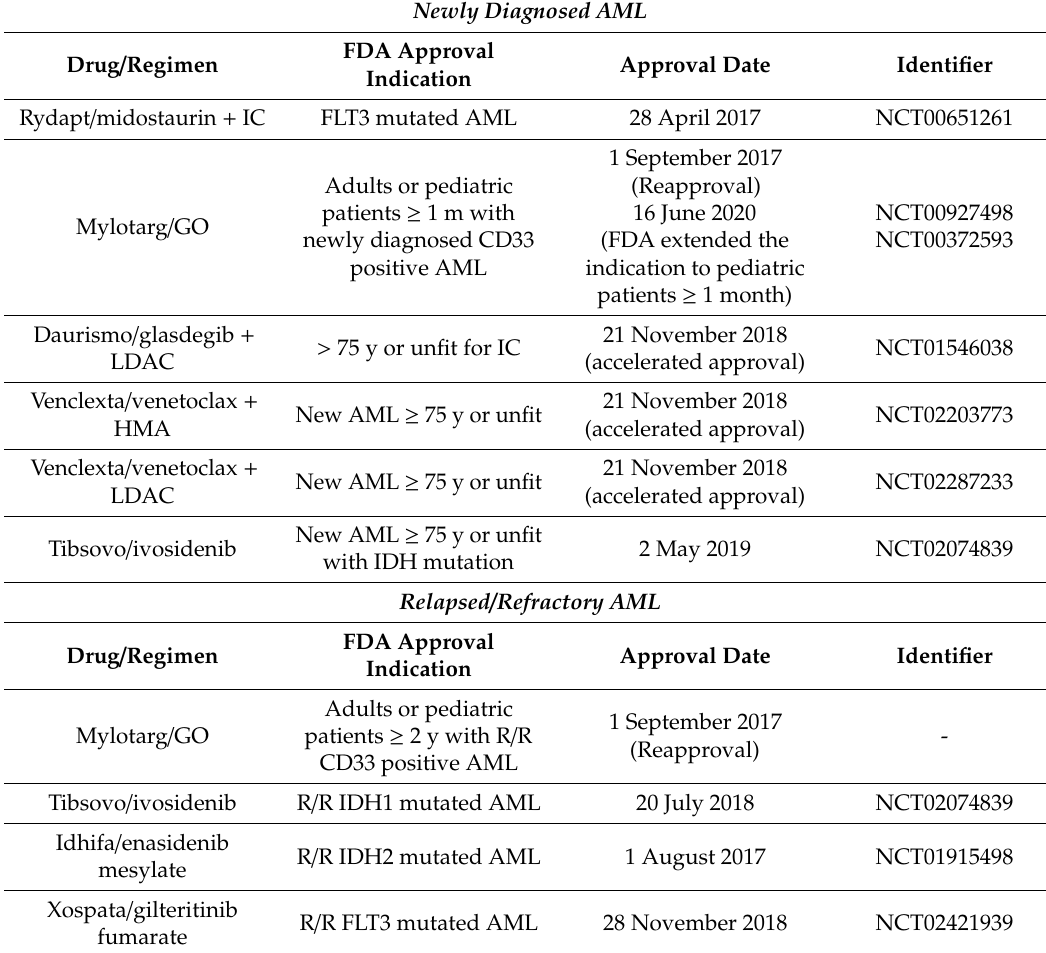
Table 1. The recent FDA-approved